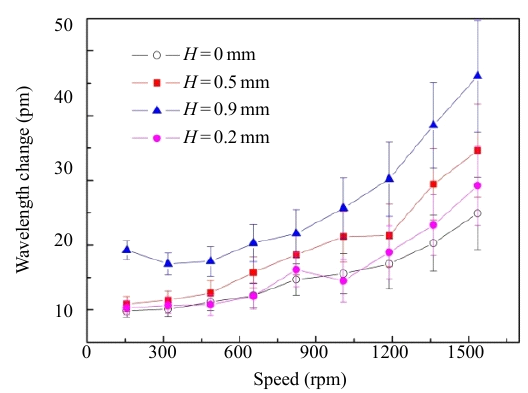
Fig. 7 Relationship between the blade deformation and